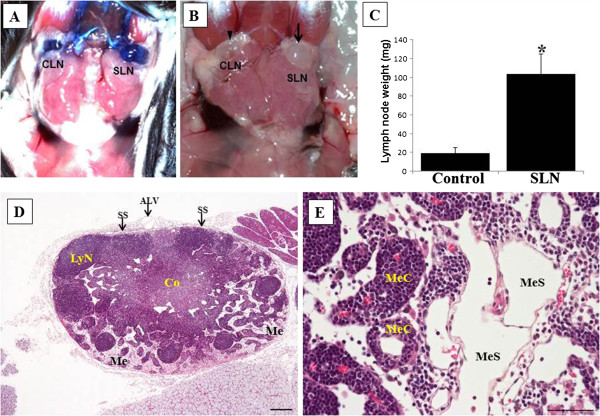
Non-metastatic cervical sentinel lymph nodes in oral melanoma-bearing mice. (A) Detection of a sentinel lymph node (SLN), showing remarkable enlargement, by injection of Evan’s blue dye. In contrast, contralateral LN (CLN) is also stained with dye, but shows no enlargement. (B) Photograph of an enlarged SLN (arrow) on the left side of the cervix and a normal-like CLN (arrowhead). (C) LN weight is significantly increased in nonmetastatic SLNs relative to control, non-draining LNs as determined by t-test. *, P<0.05. Columns, mean; bar, standard error. (D), (E) Light micrographs of hematoxylin and eosin staining in SLNs. At a lower magnification (D), remarkable enlargement of the medulla (Me) is noted. Dilated sinuses (MeS) are clearly visible in the Me of SLNs (E). ALV, afferent lymphatic vessels; SS, subcapsularsinuse; Co, Cortex; LyN, lymphatic nodule; MeC, medullary cord. Scale bars = 50 μm.